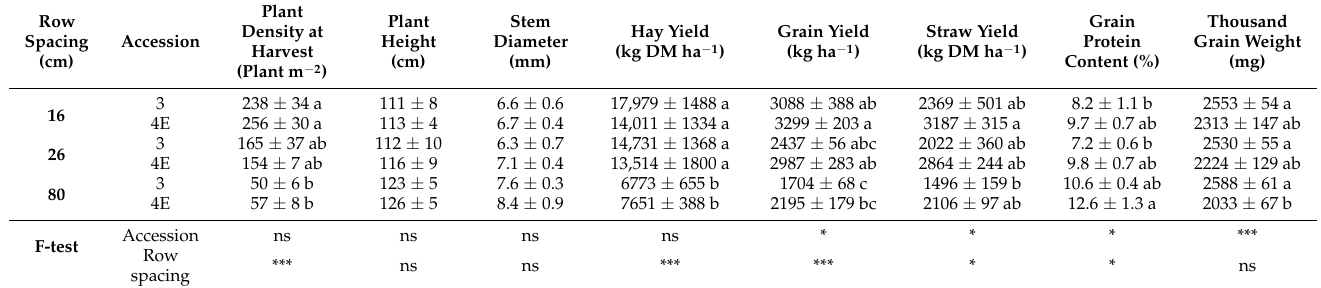
Table 5. Row spacing, plant density at harvest, yields, growth, and grain-quality parameters of quinoa accessions 3 and 4E sown in January 2020. Results are presented as mean value ± standard